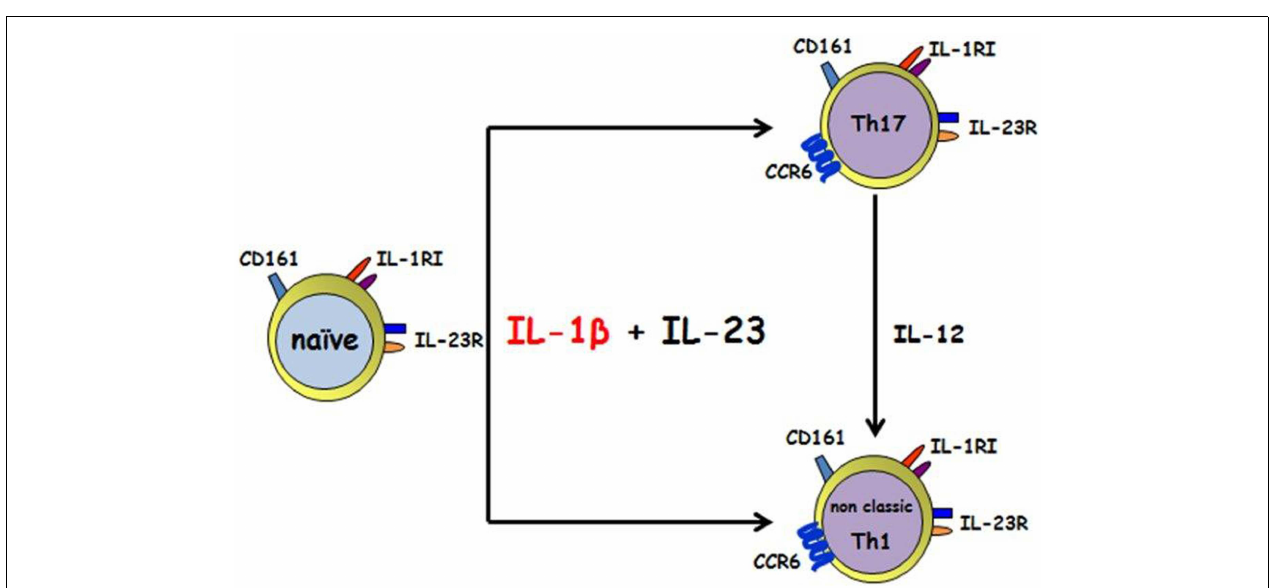
FIGURE 1 | IL-1 β and IL-23 induce the differentiation of human CD161 + precursor toward both theTh17 and the non-classicTh1 phenotype . IL-1 β together with IL-23 acts on human CD4 + CD161 + precursor to induceTh17 and non-classicTh1 effector cells.Th17 can shift toward a non-classicTh1 phenotype in the presence of